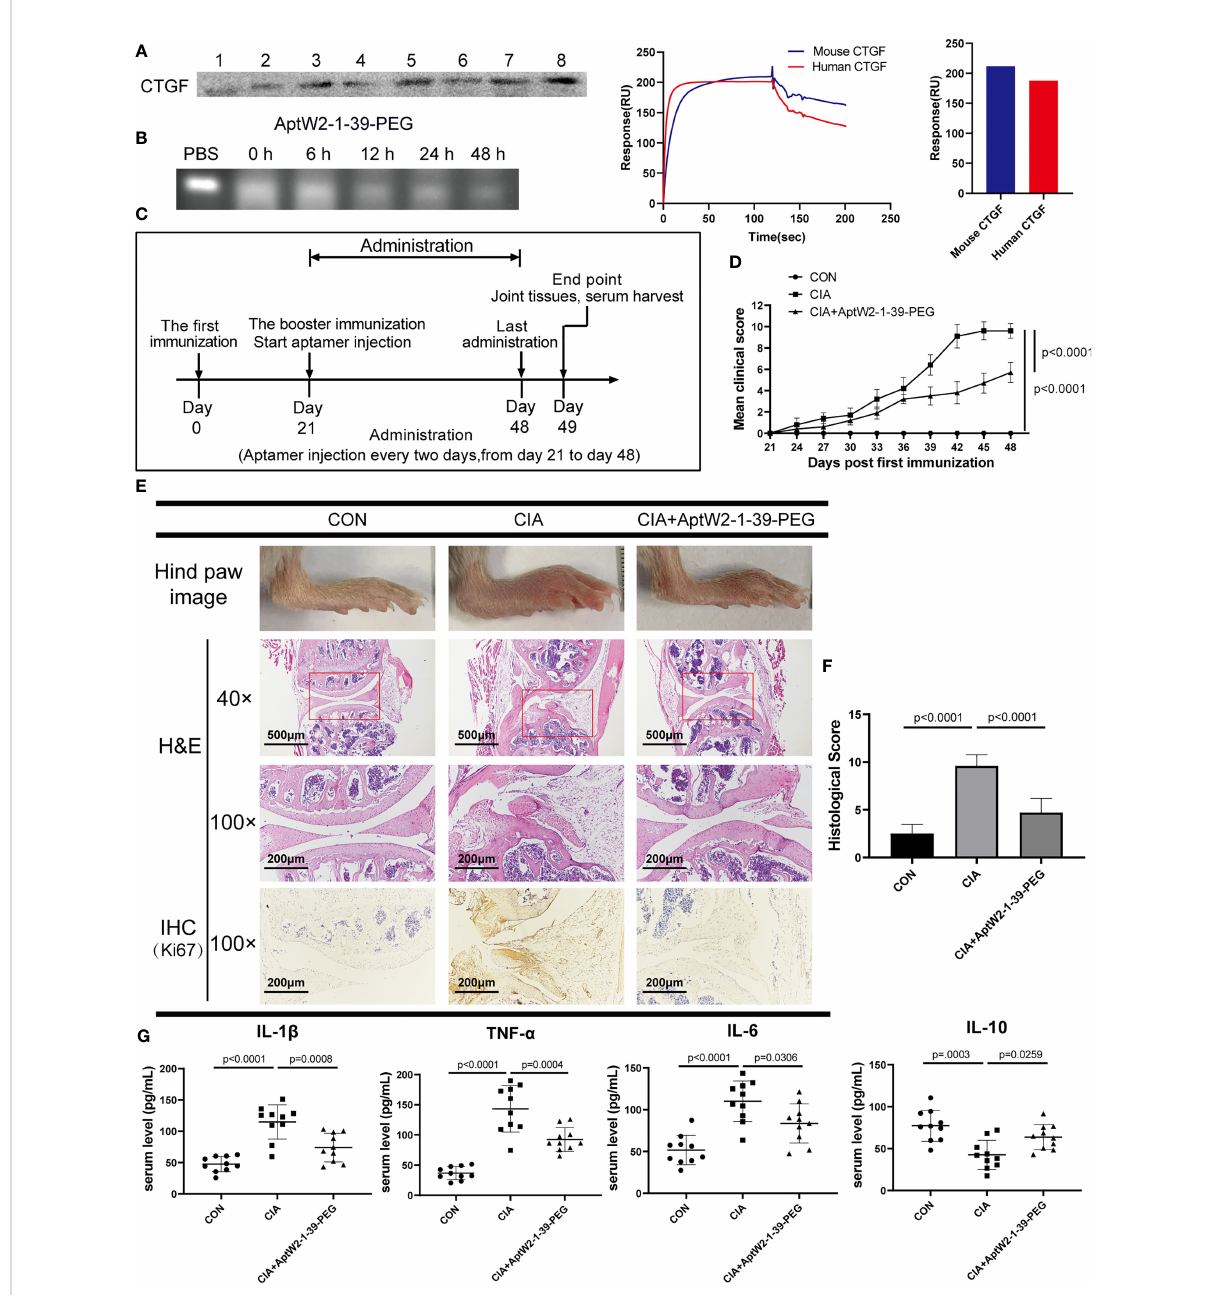
FIGURE 5 Therapeutic effect of AptW2-1-39-PEG on joint injury and in fl ammatory response in CIA model. (A) Detection of murine CTGF extracted using biotinylated AptW2-1-39-PEG and Western blotting (left). SPR assay of AptW2-1-39-PEG targeting murine CTGF (right). (B) Stability assay of AptW2-1-39-PEG incubated with murine plasma. (C) Timeline of CIA model establishment treated with AptW2-1-39-PEG ( n = 10 per group). (D) Arthritis clinical scores of the CIA mice. The scoring system was de fi ned as 0 = no evidence of erythema and swelling, 1 = erythema, and mild swelling con fi ned to the tarsals or ankle joint, 2 = erythema and mild swelling extending from the ankle to the tarsals, 3 = erythema and moderate swelling extending from the ankle to the metatarsal joints, and 4 = erythema and severe swelling encompass the ankle, foot, and digits, or ankylosis of the limb. Signi fi cance was tested using analysis of variance (ANOVA) of repeated measurement. (E) Macroscopic images and histopathology evaluation of the CIA mice. Macroscopic images of the ankles of mice were taken on day 49 before being sacri fi ced (upper panel). H&E staining of knee joints (40×, 100×, and middle panel). IHC staining of joint synovial fi broblasts (lower panel). (F) Semiquantitative scores for in fl ammatory cell in fi ltration, synovial hyperplasia, and bone destruction were assessed using H&E staining graded on a scale of 0 (normal) to 3 (severe) for 4 paws in 12. (G) The concentrations of the cytokines in the serum of the CIA mice were detected using ELISA. The data are presented as mean ±